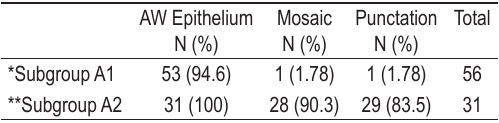
Table 1. Frequency of the basic colposcopic images (markers)